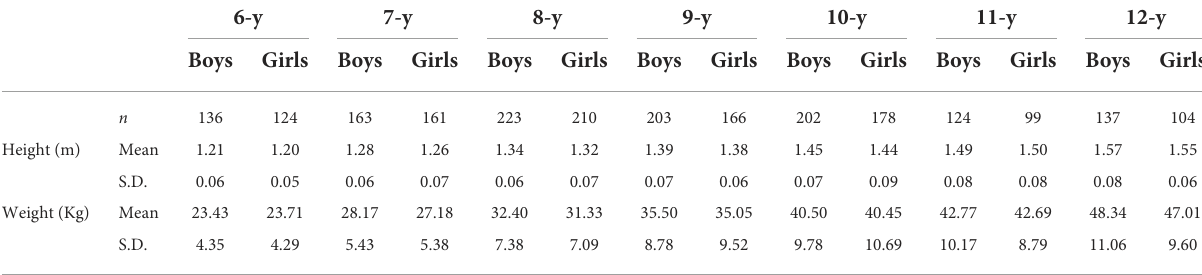
TABLE 1 Anthropometrics characteristics, divided by age and